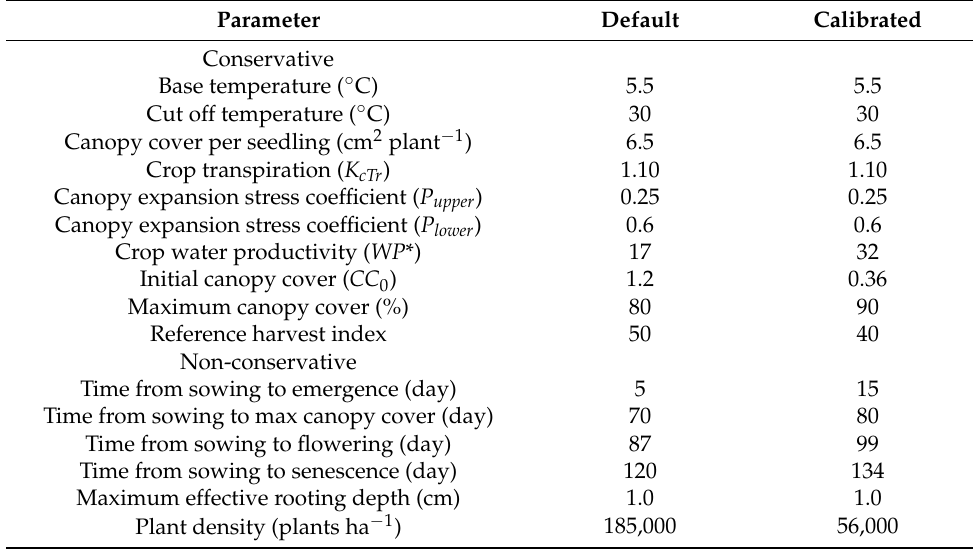
Table 2. Default and calibrated maize parameters for Aquacrop used in this